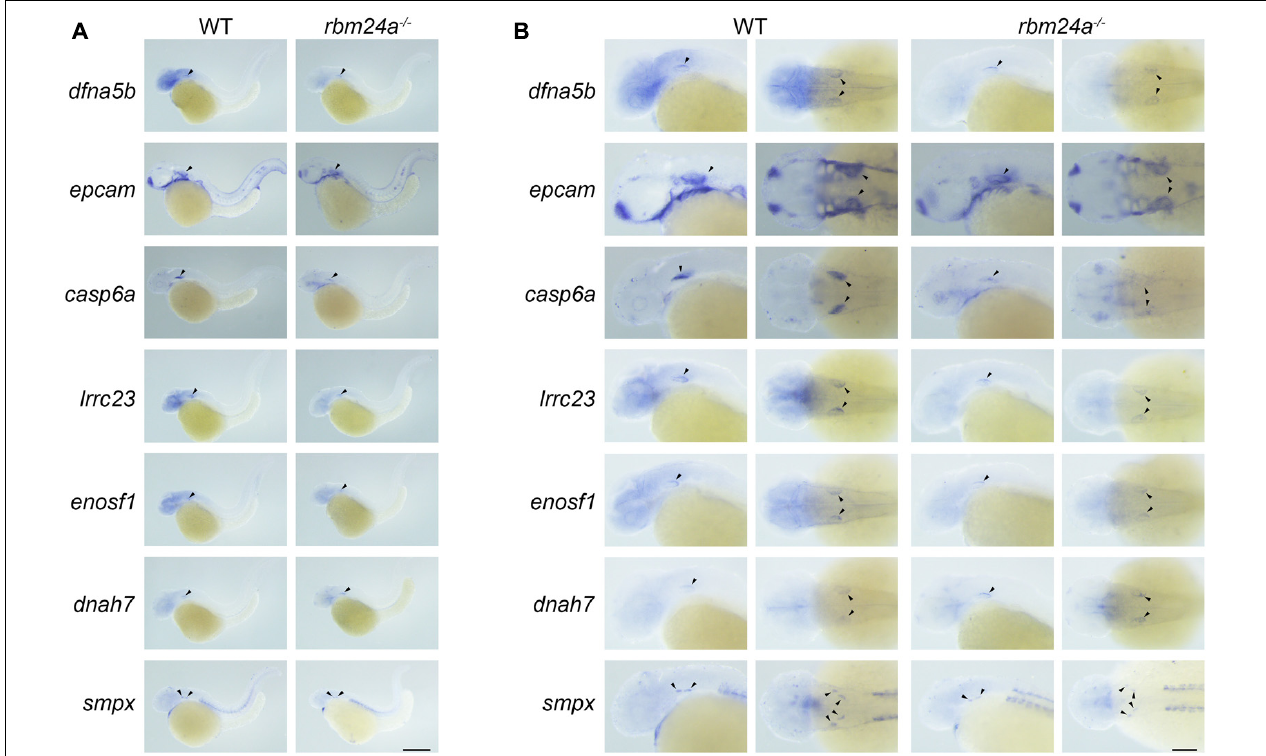
FIGURE 8 | Expression pattern of important Rbm24a target mRNAs in the zebrafish. In situ hybridization of zebrafish embryos at 34 hpf was performed to examine the expression of dfna5b , epcam , casp6a , lrrc23 , enosf1 , dnah7 , and smpx . (A) Lower magnification images. (B) Higher magnification images. Scale bars, 0.25 mm in (A) and 0.1 mm in (B)